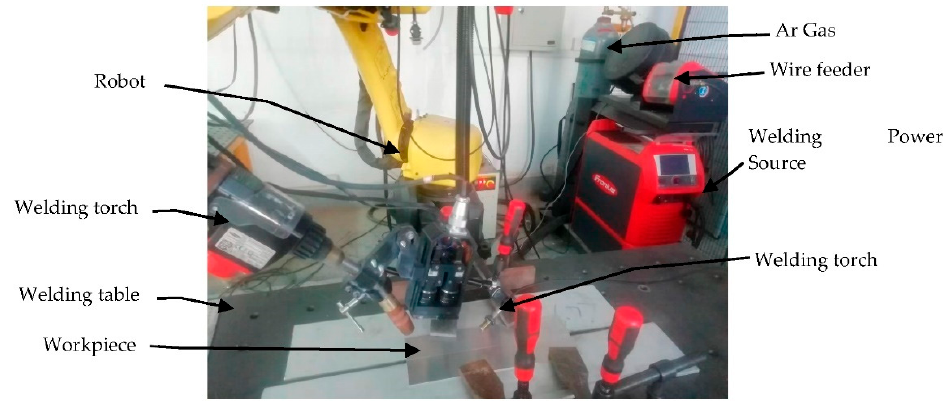
Figure 2. Experimental setup.